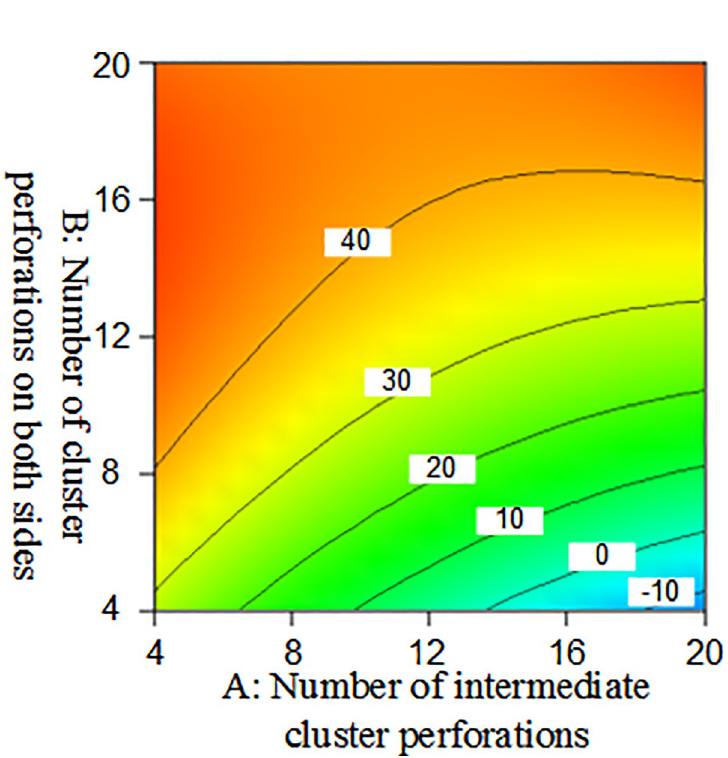
Fig 14. Two-dimensional contour map of the number of intermediate cluster perforations and the number of cluster perforations on both sides on the seam length difference.